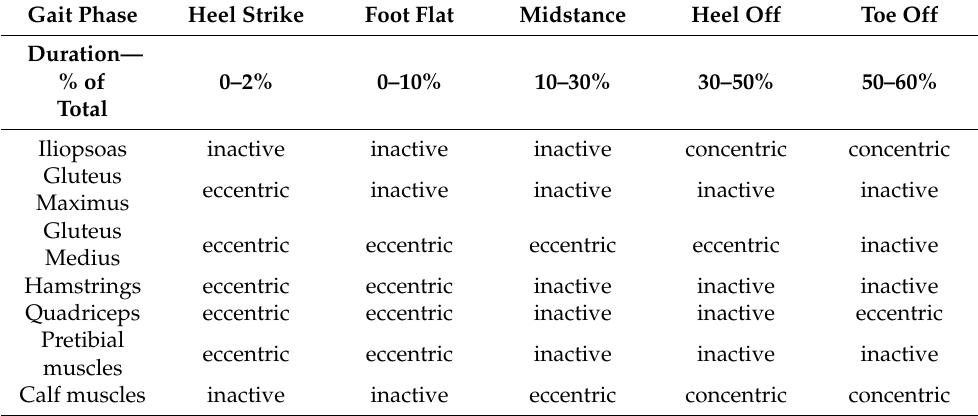
Table 1. Muscular activity throughout the stance phases of the gait cycle Table 2. Muscular activity throughout the swing phases of the gait cycle [10].